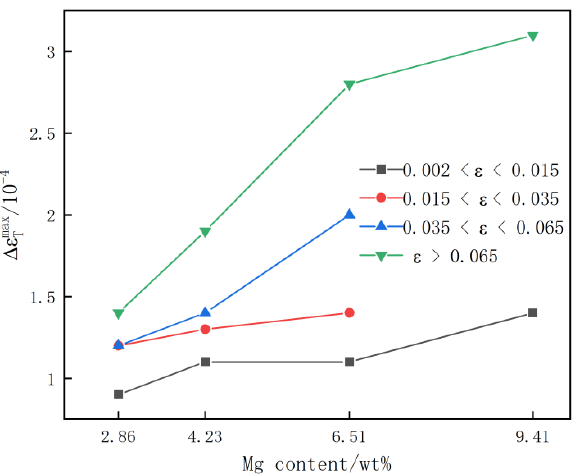
Figure 6. The change in the strain cycle of rectangular waves corresponding to high stress flow of PLC curves of quenched Al-(2.86~9.41) Mg alloy sheet deformation with increasing Mg